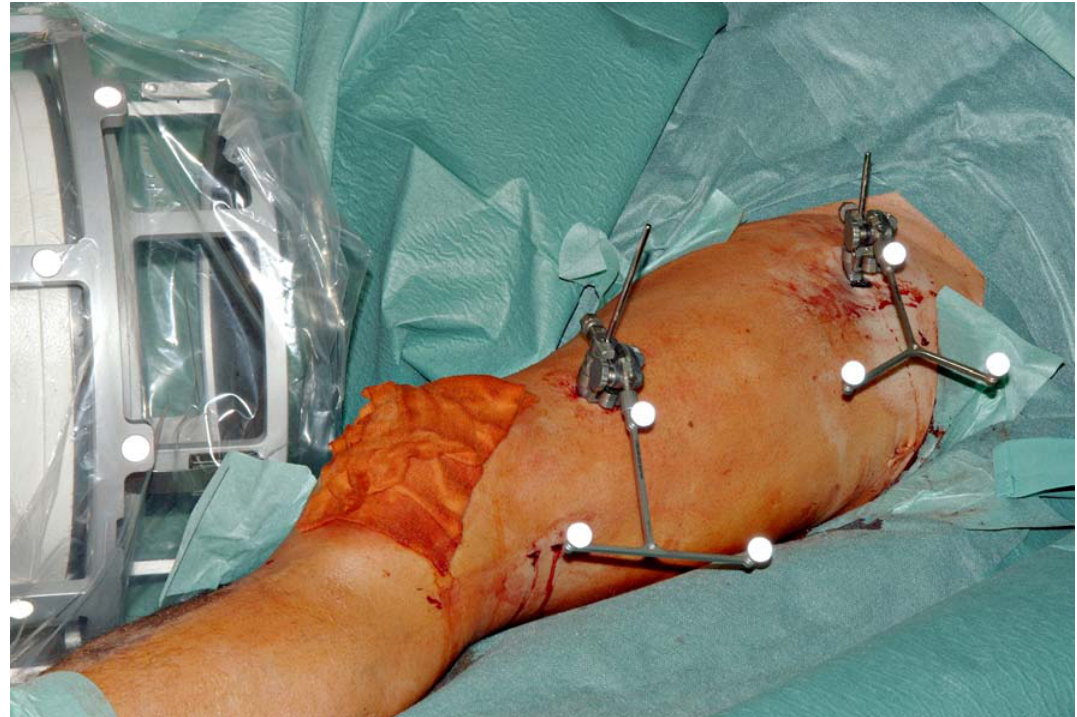
Fig. 4 Stable fixation of the reference markers, in this case at the thigh for a navigated reduction of a femur fracture, is necessary to ensure a valid navigation process. The markers require a clear reflecting surface for a correct communication with the camera